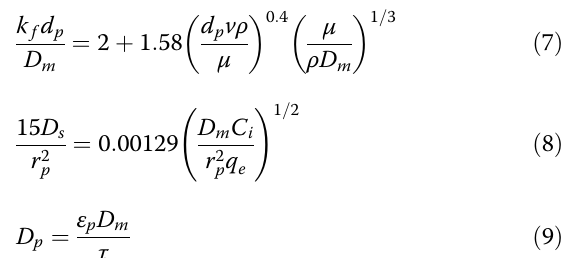
transport parameters were estimated: film or external diffusion coefficient k f , surface diffusion coefficient D s , and pore volume diffusion coefficient D p . The empirical correlations used are shown in Eqs. (7), (8), and (9) [21, 23].